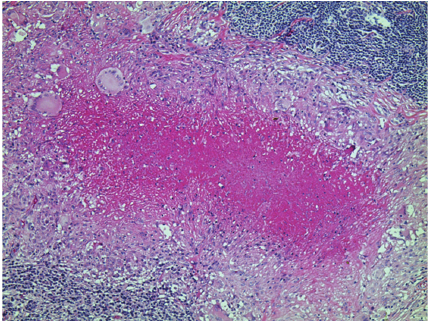
Figure 6: Histopathological image of the dissected abdominal lymph node disclosed multiple caseating granulomas with inflam- matory cells including Langhans giant cells (hematoxylin and eosin staining, ×